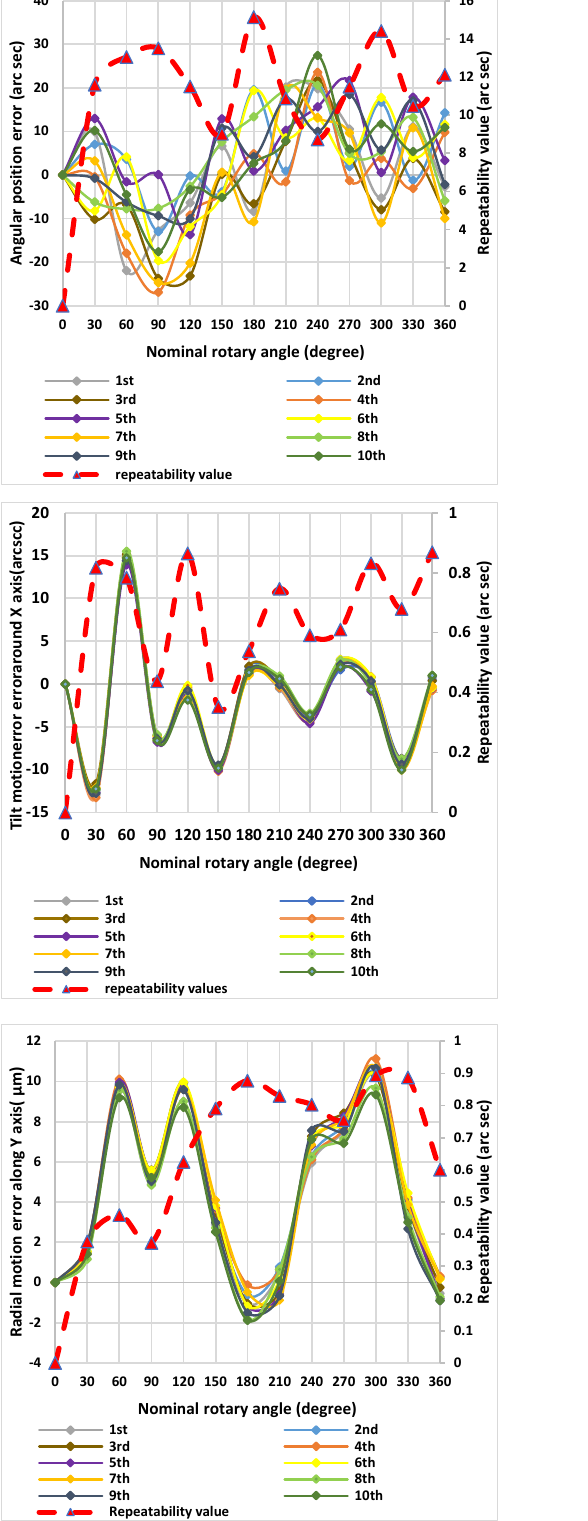
Figure 5. Measurement results of compensated six DOF geometric motion errors of a rotary axis.